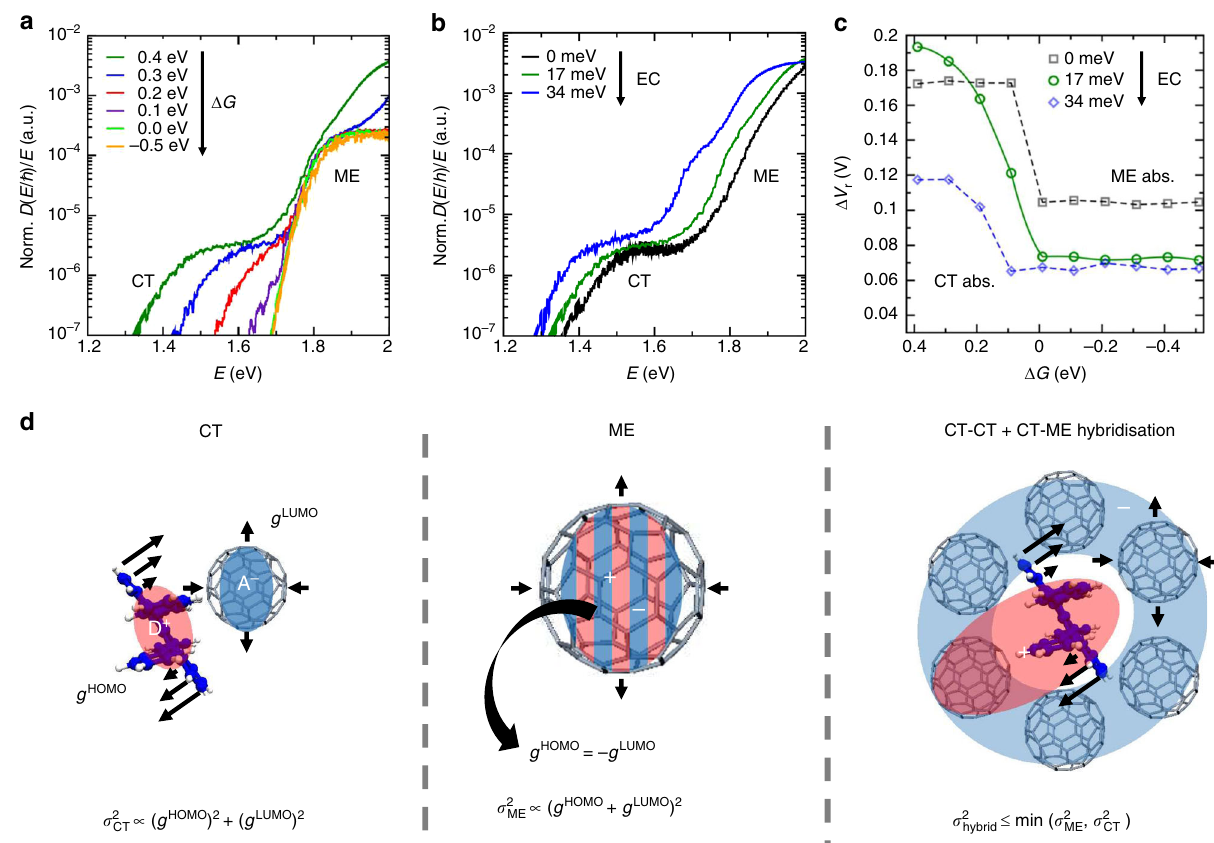
Fig. 4 Driving force and EC tuning of the EDOS and schematics of the loss reduction mechanisms. a EDOS based on TAPC:C 60 for varying CT exciton